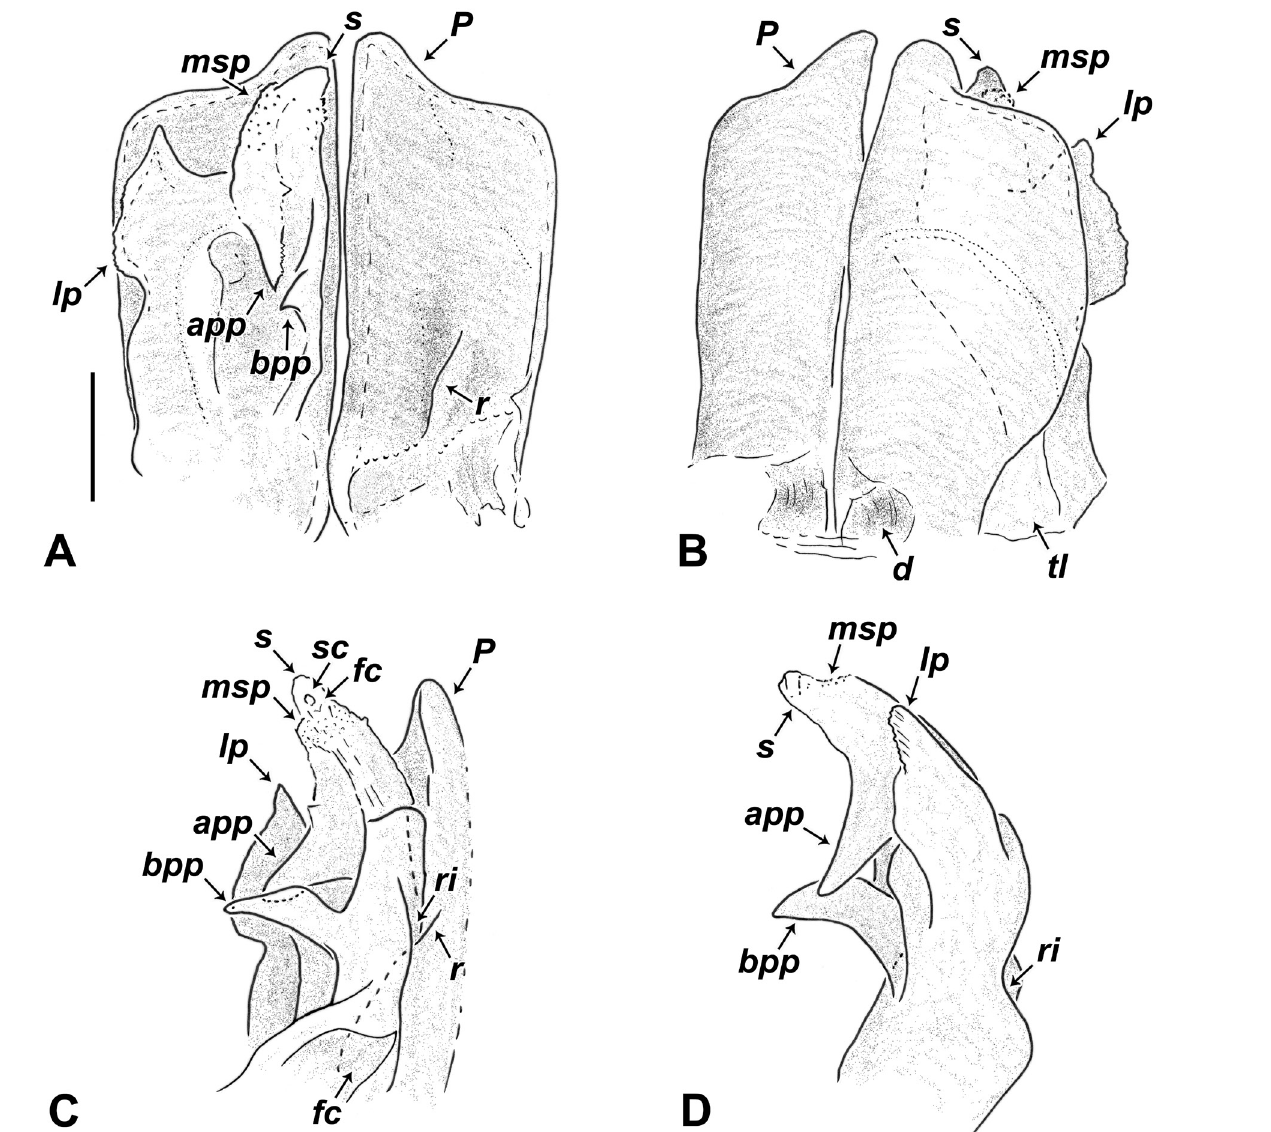
Fig. 4. Gonopods of Enghophyllum naxium , male from Mavri Islet. A . Gonopods, posterior view. B . Gonopods, antero-lateral view. C . Right gonopods, mesal view. D . Left opisthomere, lateral view. – app = apical posterior process; bpp = basal posterior process; d = deepening; fc = flagellum channel; lp = lateral process; msp = micro-spinose pillow; P = promere; r = ridge; ri = riffle; s = solenomere; sc = sperm canal; tl = triangular lamella. Scale bar: 0.2